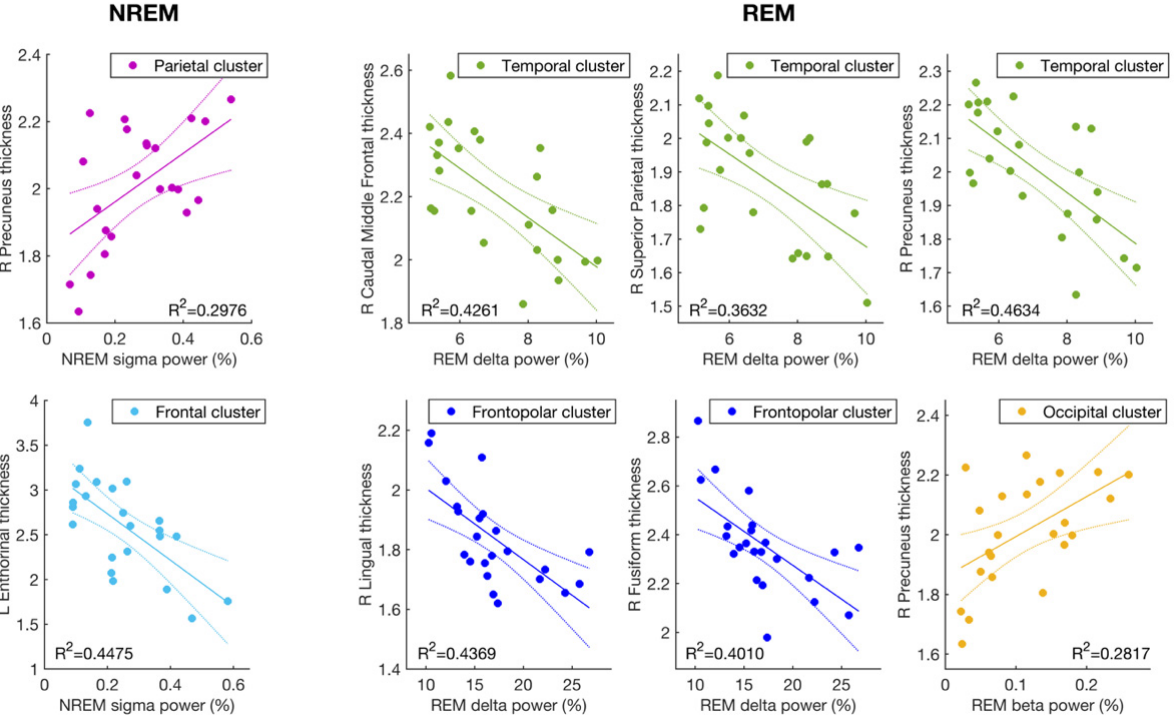
Figure 2. Correlations between cortical thickness and sleep EEG indexes in AD patients. Cortical thickness (mm) vs. EEG power (%) scatterplots for cortical areas and sleep EEG indexes show a significant relationship after FDR correction. When the thickness of an area was significantly correlated with two or more EEG clusters for the same sleep index, only data of the EEG cluster reporting the highest correlation are shown (see Supplemental Figure S2 for the others). R 2 coefficients of the linear regressions are also reported.